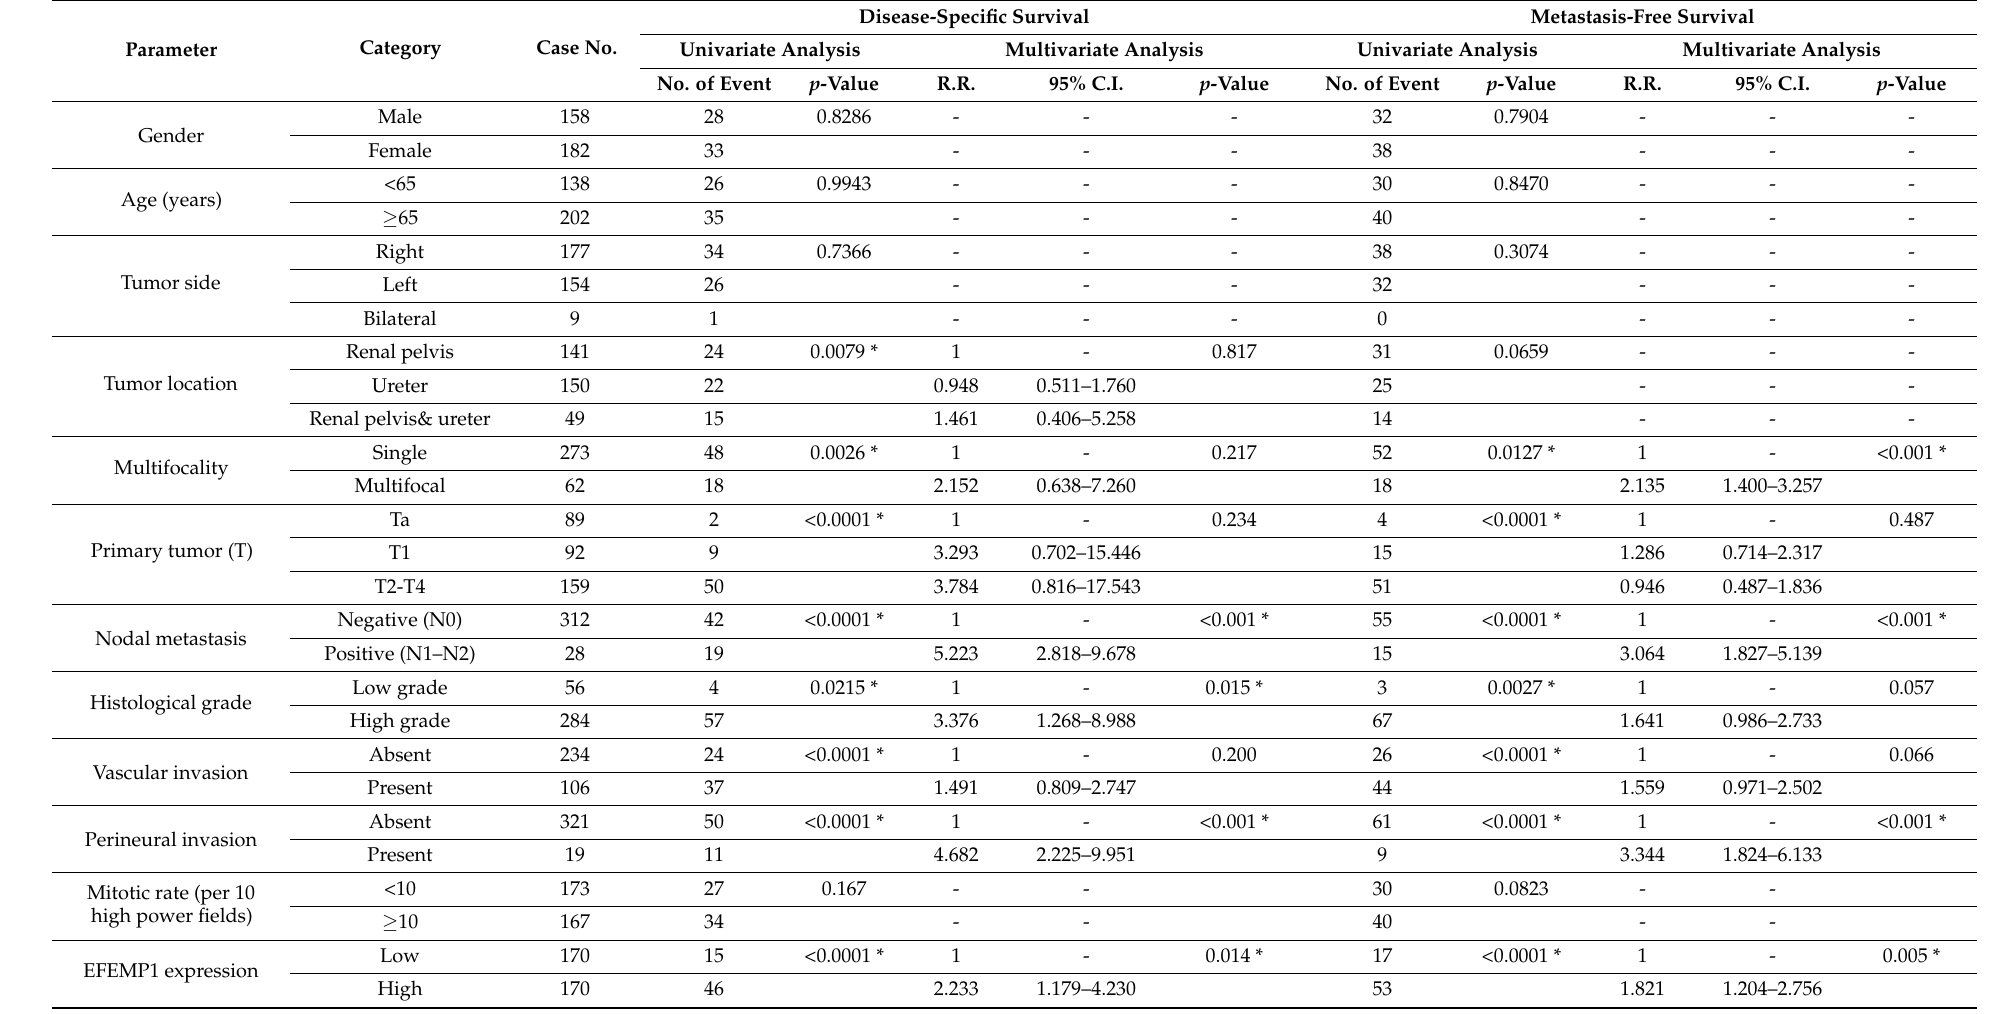
Table 3. Univariate log-rank and multivariate analyses for disease-specific and metastasis-free survivals in upper urinary tract urothelial